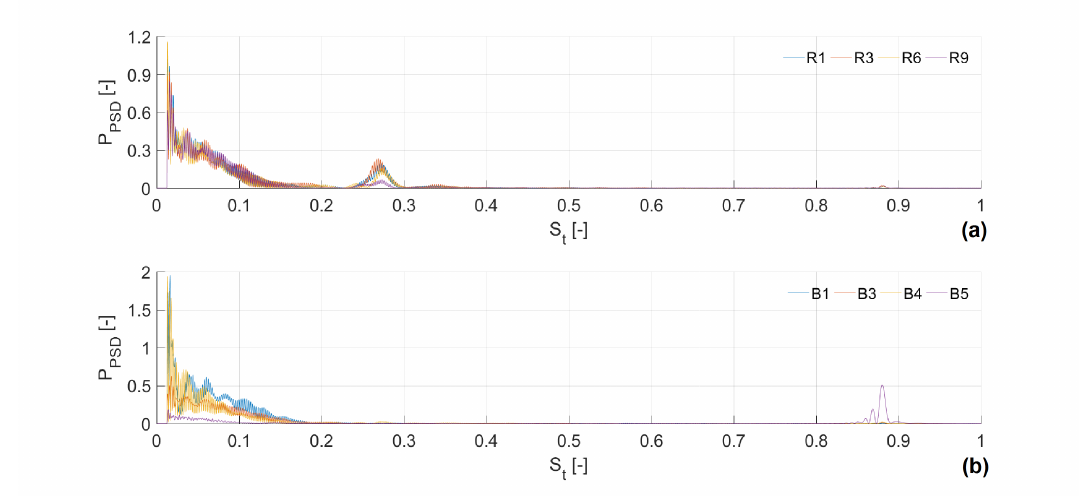
Figure 16. ( a ) Normalized power-spectra of the pressure signals acquired from circumferential runner points; and ( b ) monitoring points on the